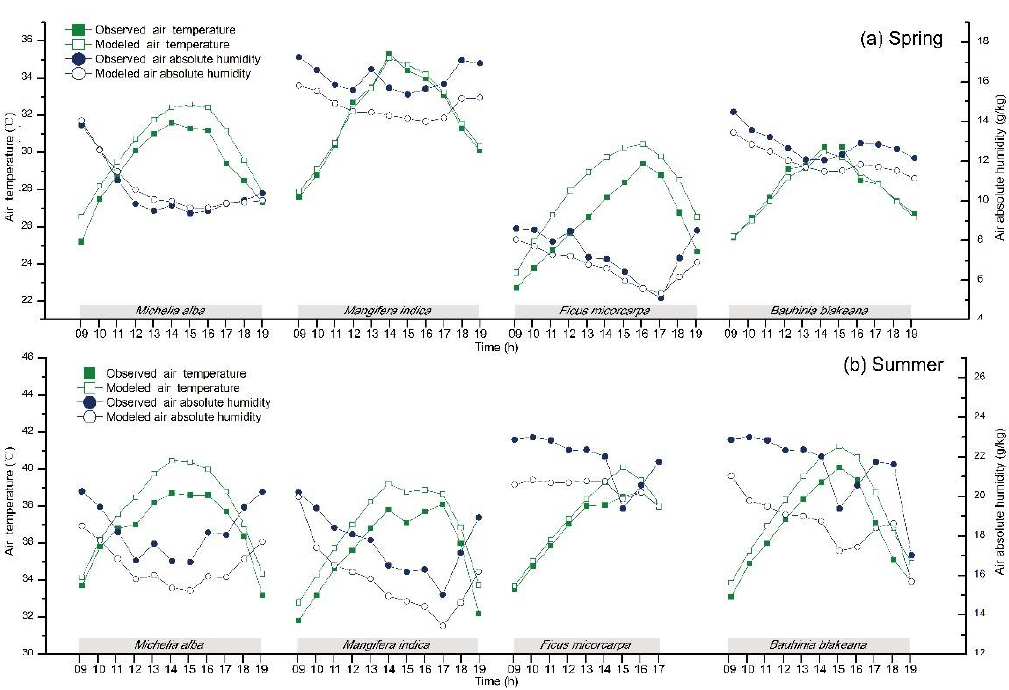
Figure 5. Comparison of modeled and observed air temperature and humidity in treeless areas: ( a ) in spring ( b ) in summer.